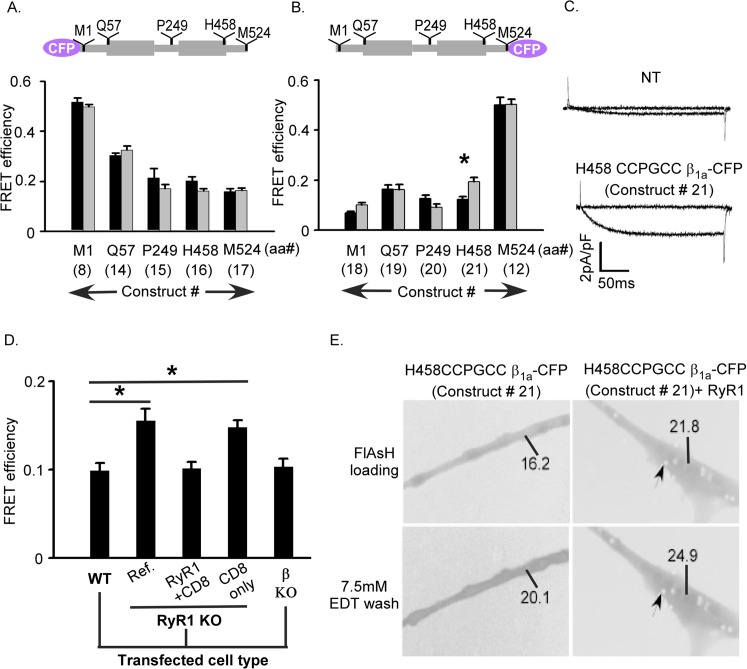
Intramolecular FRET in the ß1a subunit depends upon donor-acceptor position and RyR1 expression.(A) FRET efficiencies for ß1a subunit constructs in myotubes when CFP donor was located at the N-terminus and CCPGCC acceptor site was tested at five different positions of ß1a labeled M1 (construct 8), Q57 (construct 14), P249 (construct 15), H458 (construct 16) and M524 (construct 17), as indicated in schematic above bar graphs. (B) FRET efficiencies for same ß1a subunit constructs in myotubes except the CFP donor was located at the C-terminus (construct 12, 18, 19, 20 and 21). For both panels A and B the ß1a constructs were expressed in wild type (black) or RyR1 KO (gray) myotubes. Only the construct H458-CCGPCC ß1a-CFP (construct 21) displayed significant difference FRET efficiency (*p<0.001) in the presence (in WT 0.12 ± 0.01) versus absence (in KO 0.19 ± 0.01) of RyR1 (in Table 1 boxed). (C) Ca2+ current expression at test potentials of –30 mV and +30 mV in ß1 KO myotubes expressing H458-CCGPCC ß1a-CFP (construct 21) compared to non-transfected (NT) ß KO control which demonstrates that this construct forms functional ß subunits. (D) Comparison of FRET efficiency of H458 CCPGCC ß1a-CFP (construct 21) transfected in either WT or dyspedic myotubes. Transfection of RyR1 into dyspedic myotubes eliminated the increase in FRET observed in the absence of RyR1. The RyR1 expression marker (CD8) or the presence of endogenous ß1a subunits has no effect on the measured FRET efficiencies. The FRET efficiency of construct 21 was 0.12 ± 0.01, when it was transfected in either wild type (WT) or ß KO or RyR1 KO cells in presence of RyR1 + CD8 plasmids (triple transfected). Additionally a comparable FRET efficiency observed in RyR1 KO cells between construct 21 alone (0.19 ± 0.01) and construct 21 with CD8 plasmid co-transfection (0.18 ± 0.01), which was significantly higher than the WT (*p<0.001; see results in Table 1) (E) Expression and intramolecular FRET of H458CCPGCC ß1a- CFP alone and co-transfected with RyR1 in dyspedic myotubes with the number represents the fluorescence intensity of the region in the myotube and the arrow indicated CD8 beads.